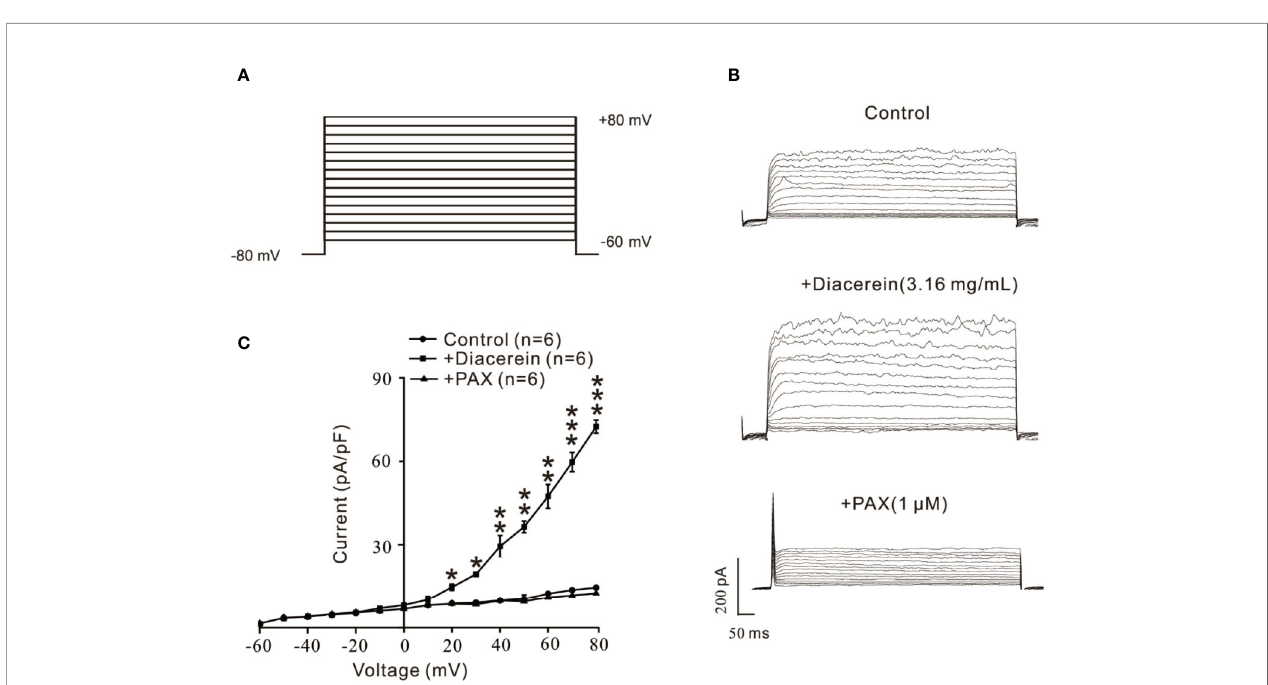
FIGURE 10 | Diacerein strengthened K + currents. (A) Large-conductance Ca 2+ -activated K + (BK) currents was recorded under the ramp voltage ranged from − 80 to +80 mV at 10 mV increments. (B) Representative recording of K + currents under the conditions of control (upper), 3.16 mg/ml diacerein (middle), and 1 m M paxilline (lower) at different voltages. (C) Current-voltage curve was constructed based on the results of six cells from six mice. *, p < 0.05; **, p < 0.01; ***, p <